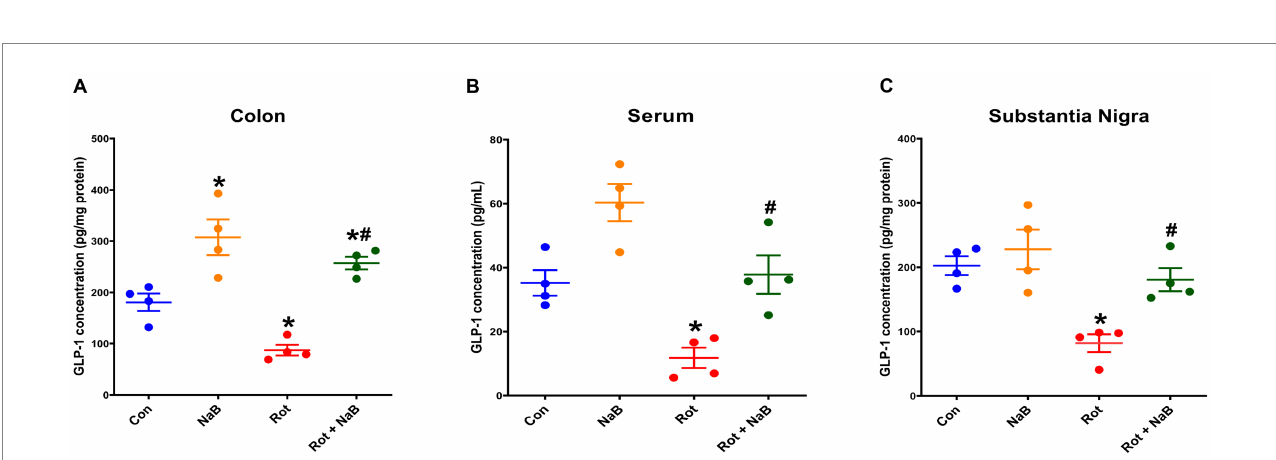
FIGURE 7 NaB improved rotenone-induced reduction of GLP-1 levels. Bar plots of GLP-1 levels in (A) colon, (B) serum, and (C) substantia nigra. n = 4 per group. The data represent the mean ± SEM. * p < 0.05 vs. Con group; # p < 0.05 vs. Rot group. Con: control; GLP-1: glucagon-like peptide-1; NaB: sodium butyrate; Rot: